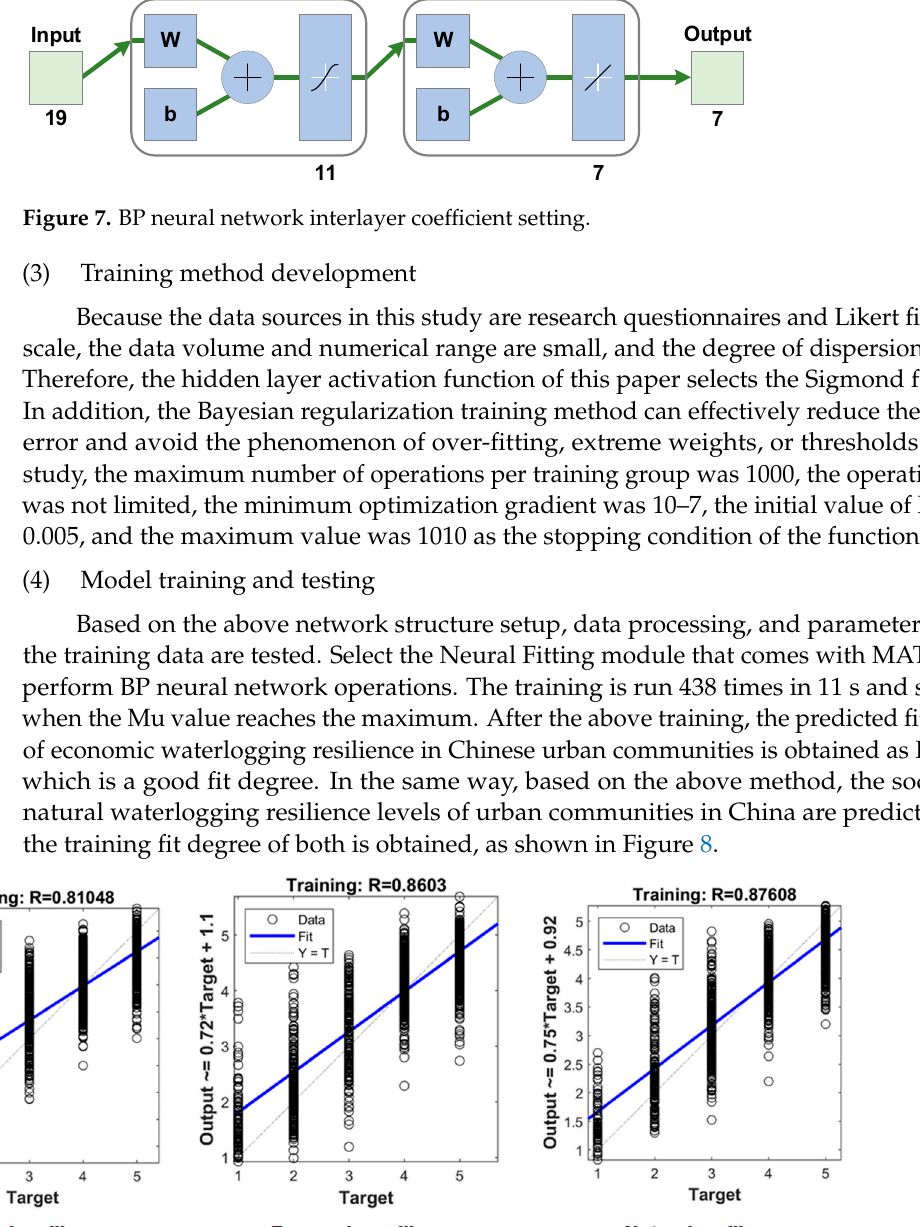
Figure 7. BP neural network interlayer coefficient setting.